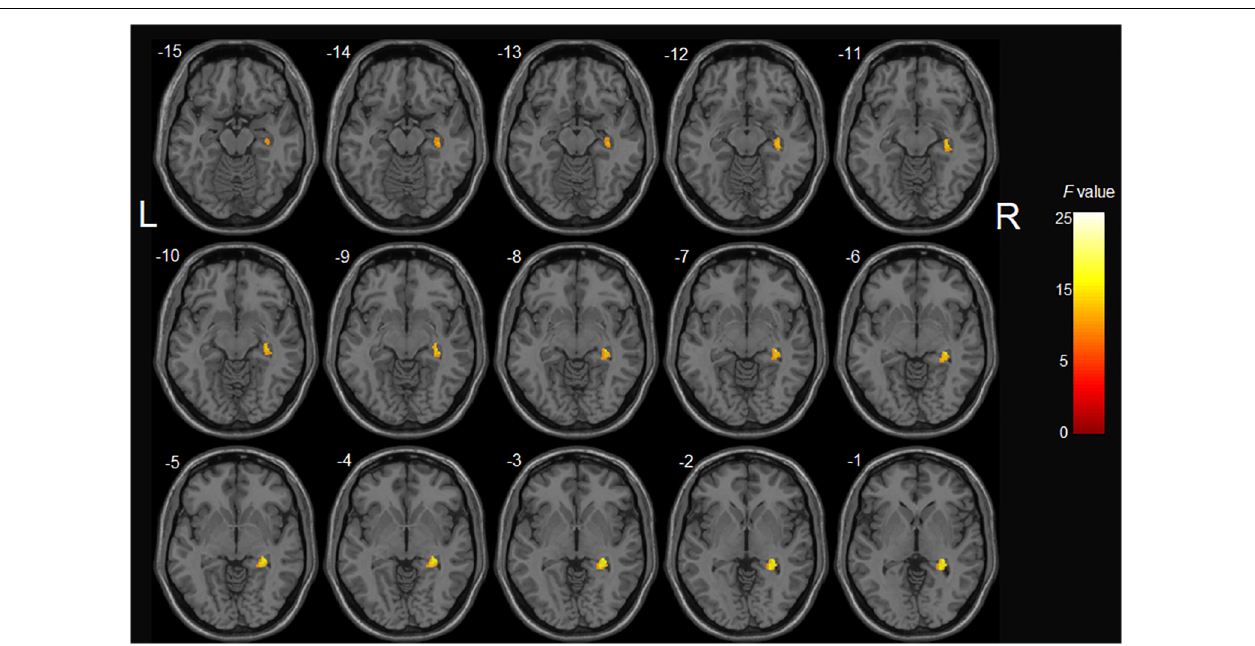
FIGURE 2 | The main effect of APOE genotype on GMV in aMCI patients: among aMCI patients, APOE ε 4 carriers demonstrated decreased gray matter volume of the right hippocampus compared with APOE ε 4 non-carriers. TABLE 3 | Diagnosis effect in all subjects with APOE ε 4 allele and without APOE ε 4 allele. Brain regions (AAL) Cluster size